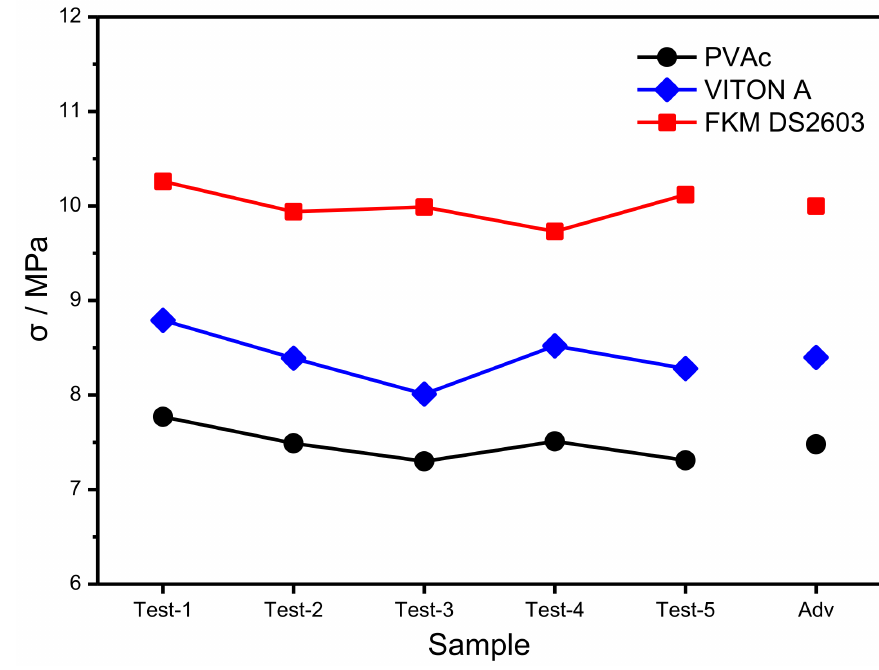
Figure 5. Compressive strength of PBX with different